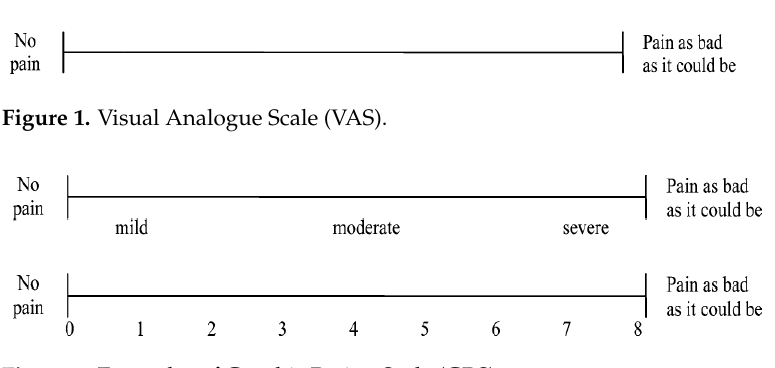
Figure 2. Examples of Graphic Rating Scale (GRS).